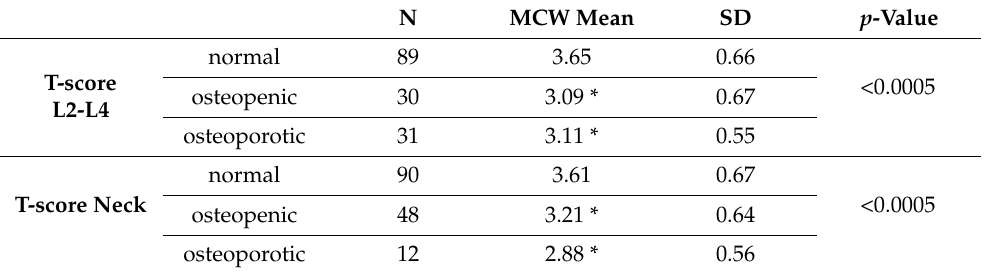
Table 5. Correlation between T-score and MCW.